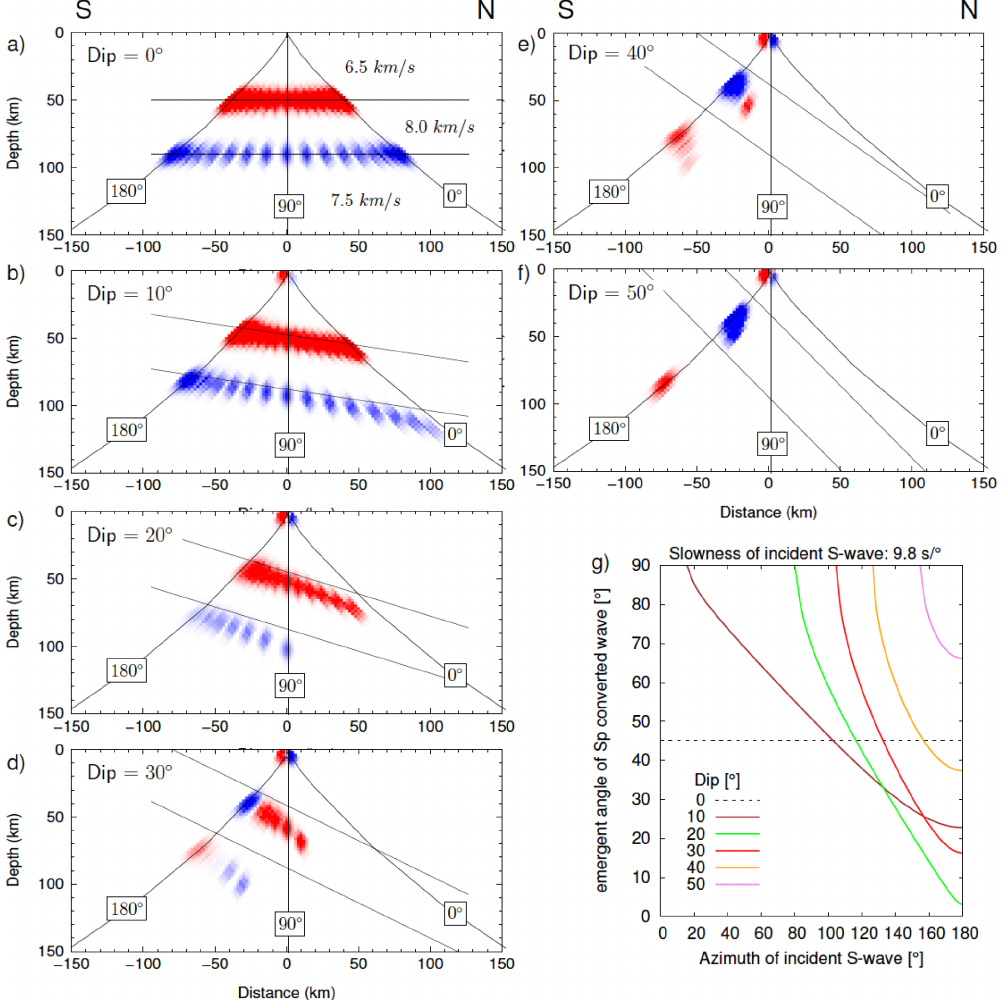
Figure 4. Common conversion point (CCP) stacking results of synthetic S-receiver functions generated with the RAYSUM package (Fred- eriksen and Bostock, 2000) for different inclination angles of a high-velocity zone (slab). The converters of the input models are depicted as black lines. The velocities used for the modeling are given in (a) . The locations of the converters as reconstructed by CCP stacking of the synthetic S-receiver function amplitudes are shown in red (positive) and blue (negative). As for the depth transformations, a 1-D velocity model is used for calculating the conversion points, resulting in the offset between input and recovered anomalies for inclined discontinu- ities. (g) The emergent angles (relative to the slab surface) of the Sp converted and transmitted waves are calculated dependent on the back azimuth of the incident S wave for the velocity contrast at the lower boundary of the slab. The results for the different considered inclination angles (dip) are shown in different colors. The range of back azimuths for which Sp converted energy is transmitted is becoming smaller for increasing dipping